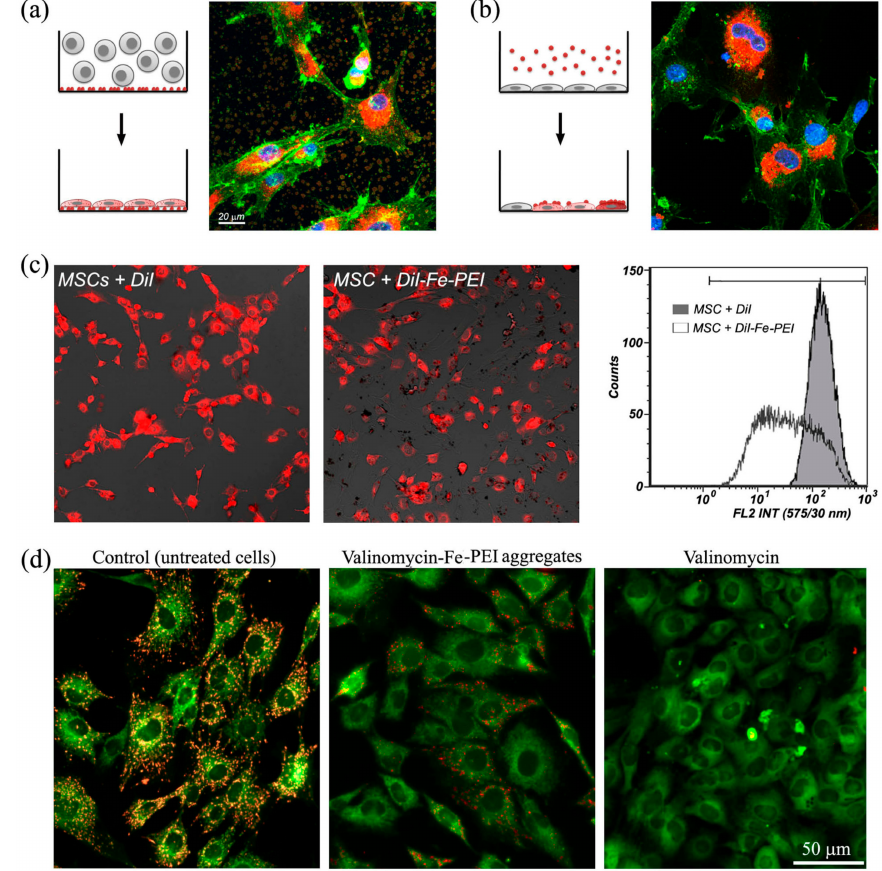
Figure 3. Delivery efficacy of molecules into MSCs using Fe-PEI. ( a , b ) Confocal microscopy images illustrating MSCs (actin staining with Oregon Green-labelled WGA) stained with DiI (red) after 24 h of direct contact between DiI-Fe-PEI aggregates with MSCs. The direct contact was achieved by seeding unstained MSCs on tissue culture plates coated with DiI-Fe-PEI aggregates ( a ) or by adding DiI-Fe-PEI aggregates into the culture medium of pre-adhered cells ( b ). Note that every single cell was fluorescent when allowed to adhere on the uniformly distributed aggregates ( a ); in contrast, when aggregate suspension was introduced into culture medium on the top of already adhered cells, only cells that established direct contact with DiI-Fe-PEI aggregates incorporated fluorochromes ( b ); ( c ) Quantification of red fluorescence in MSCs after interaction with DiI-Fe-PEI aggregates. ( d ) Representative picture of MSCs stained with JC-1 (red-orange for aggregate form of JC-1 and green for monomeric form) before ( left image) and after exposure to valinomycin as such ( right image), or valinomycin incorporated into Fe-PEI aggregates ( middle image). Intact mitochondria appear as punctuate red fluorescence whereas depolarized mitochondria exhibit the characteristic diffuse green monomer